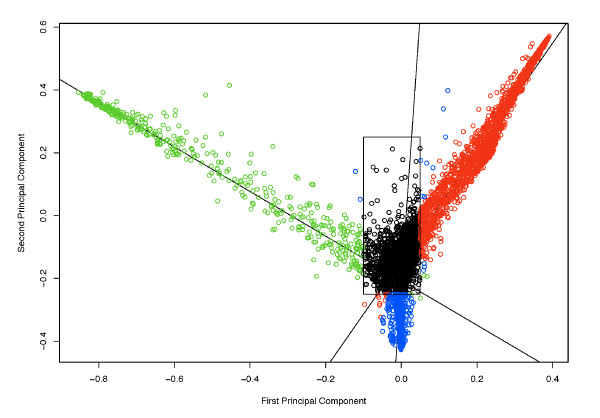
Principal components analysis of the amino acid frequency matrix from 21 protein data sets. Each site is indicated by an open circle. The classes and the regression lines were determined as shown in the main text.